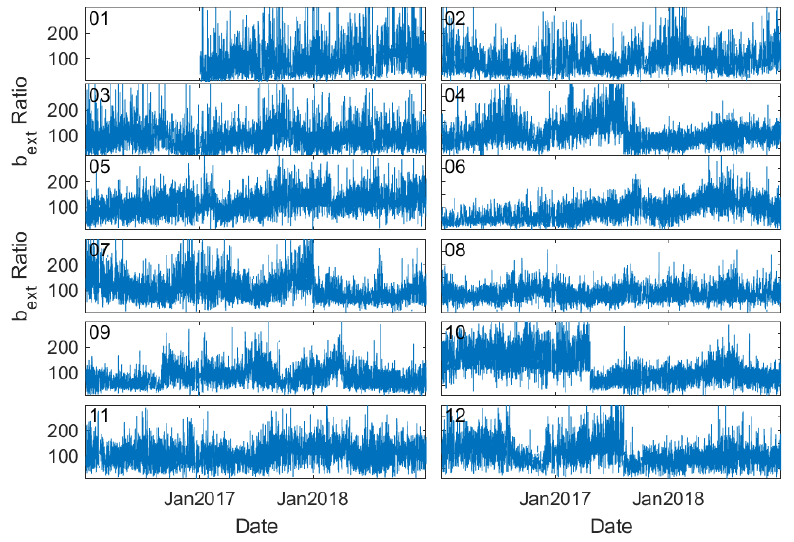
Figure 7. Time series of the ratio of b ext at an individual station to the regional mean in Tianjin, a municipal city near Beijing.